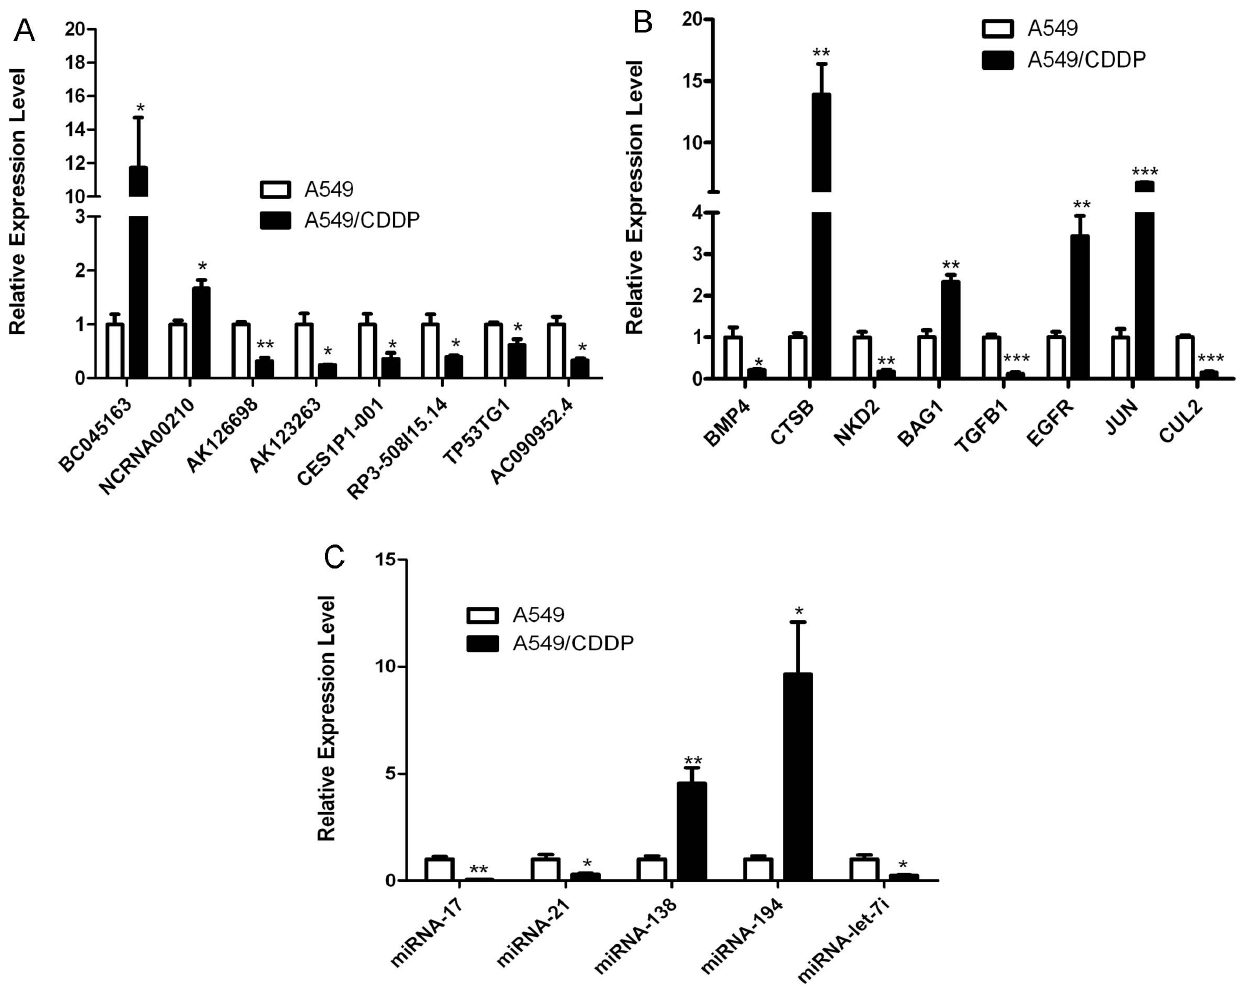
Figure 2. Validation of microarray data by realtime RT-PCR. The relative amount of each mRNA (A) and lncRNA (B) was normalized to 18S rRNA, and each miRNA (C) was normalized to U6 snRNA. Data in histograms are means 6 SD, *P , 0.05, **P , 0.01, ***P , 0.001 compared with A549 (t test).